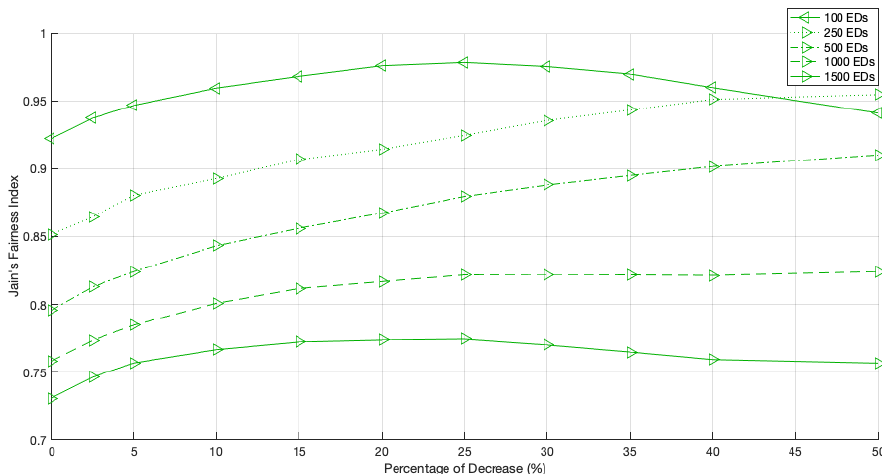
Figure 16. Network fairness for 5 GWs, different network sizes and different PoD.